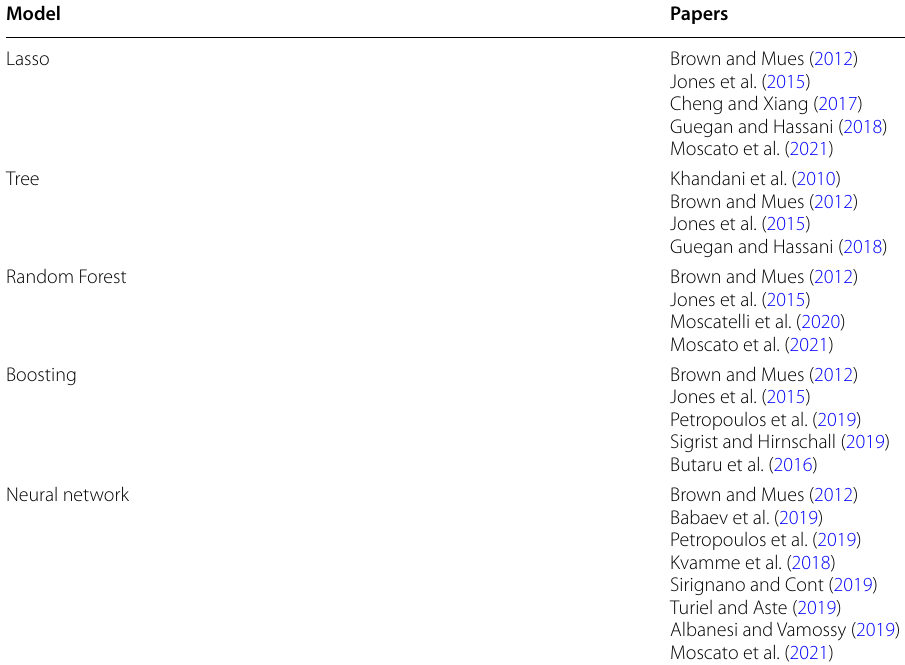
Table 13 Summary of papers on ML and credit default, by methodology used Model